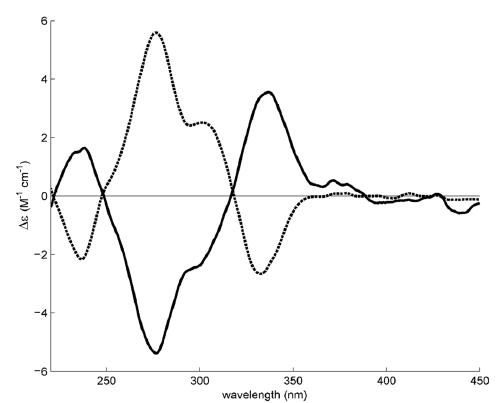
Figure 4. Experimental methanol ECD spectra of MDPV fraction E1 (solid line) and fraction E2 (dashed line). As there was a difference in concentration between the ECD samples, the intensity of the E2 fraction spectrum was amplified 2.5 times for better comparison.